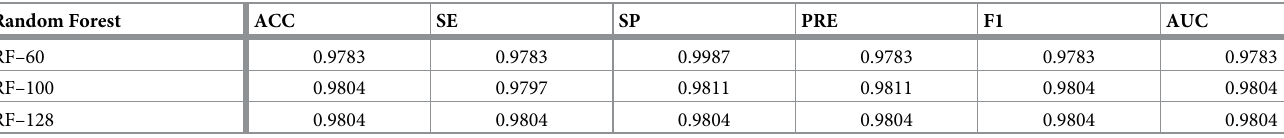
Table 6. Random forest results (2 nd experiment).